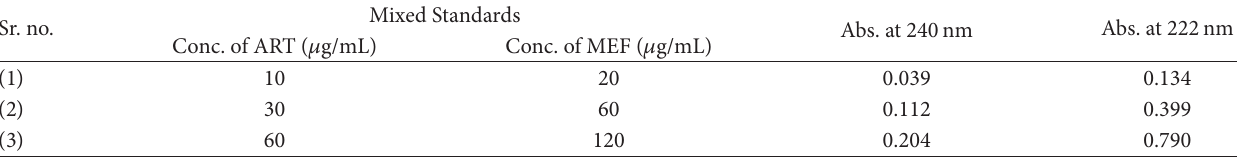
T 3: Absorbance of mixed standards containing ART and MEF.